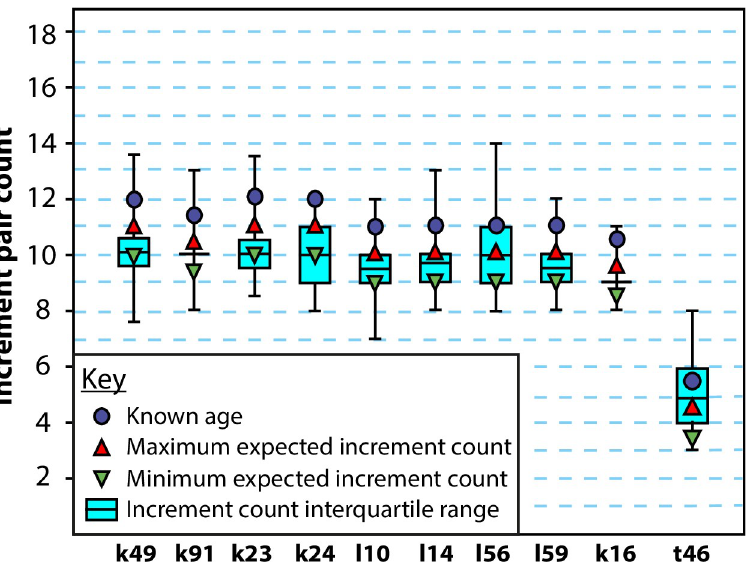
Fig 9. Comparison between known increment pair counts and those estimated by the proposed cementum increment counting algorithm. PPCI SR CT data shown are from M1 teeth of ten Macaca mulatta individuals of known age (see Table 1). Cyan boxes indicate the interquartile range around the mean estimated increment count, indicated by the thick black line. Whiskers represent the extreme lower and upper estimated counts. Blue circles indicate known age of each individual. Red triangles indicate the maximum and inverted green triangles indicate the minimum expected increment count for each individual based on the approximate age-of-eruption of the M1 at 18 months of age in Macaca mulatta